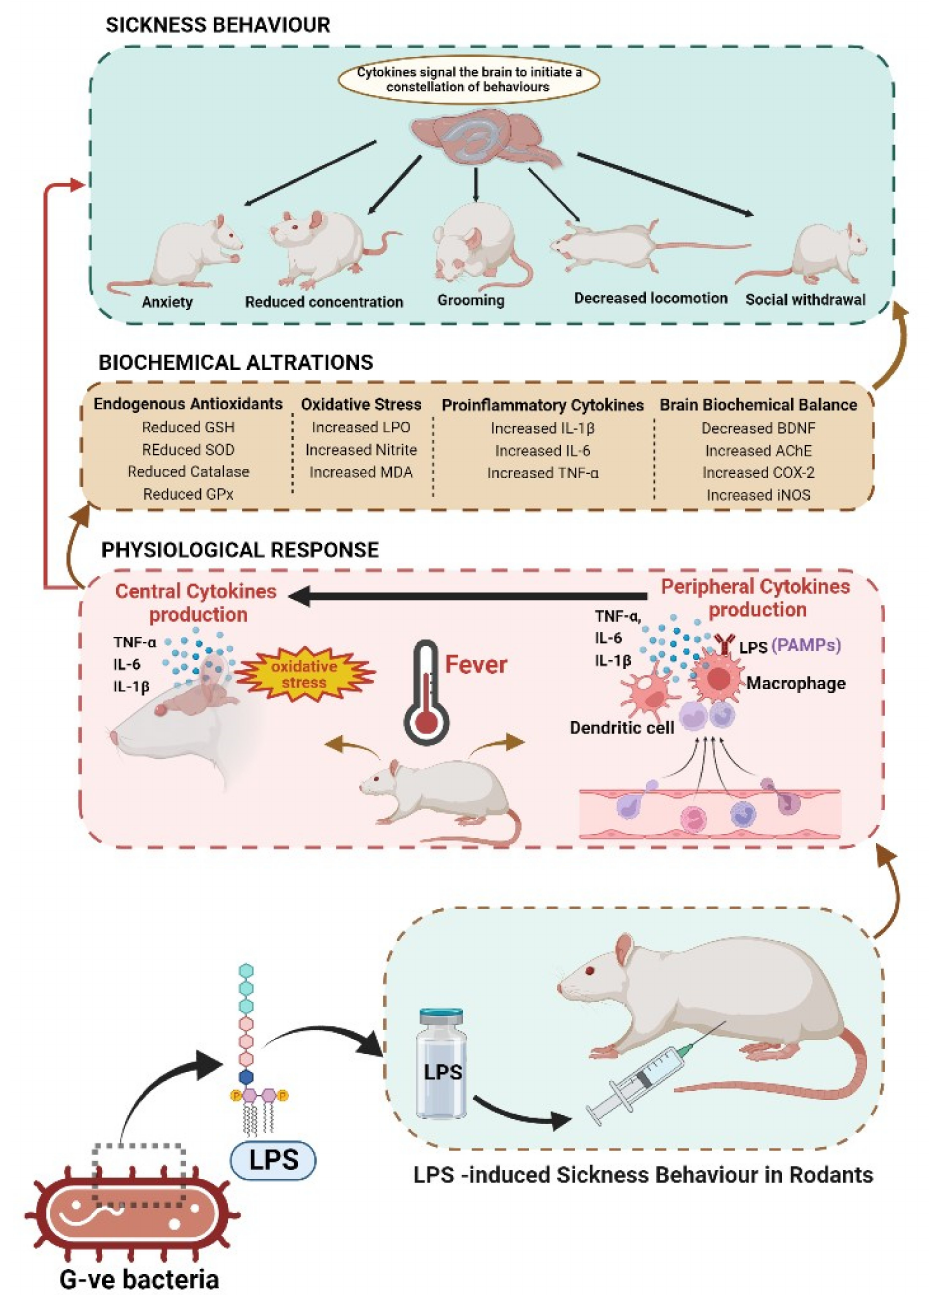
Figure 3. Physiological, behavioural, and biochemical alterations in LPS-induced sickness behaviour in rodents. Figure created with the help of